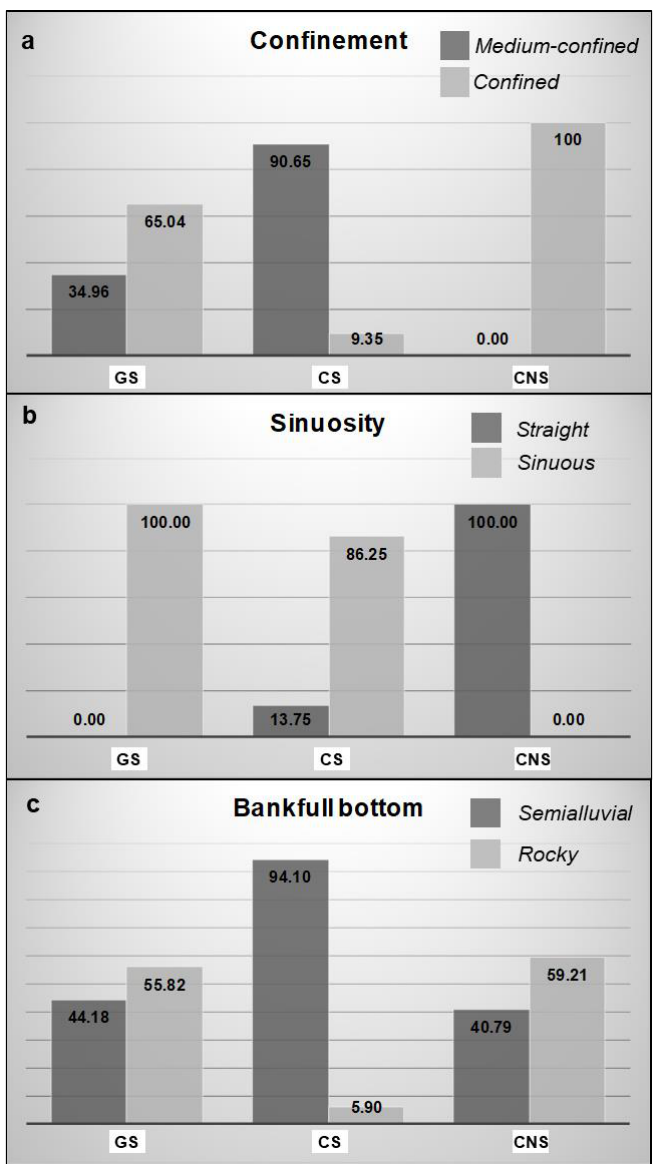
Figure 6. Graphs of Confinement, Sinuosity and Bankfull bottom configuration along the three investigated segments. ( a ) GS — Gole del Sesia; ( b ) CS — Classico del Sesia; ( c ) CNS — Canyoning Sorba.